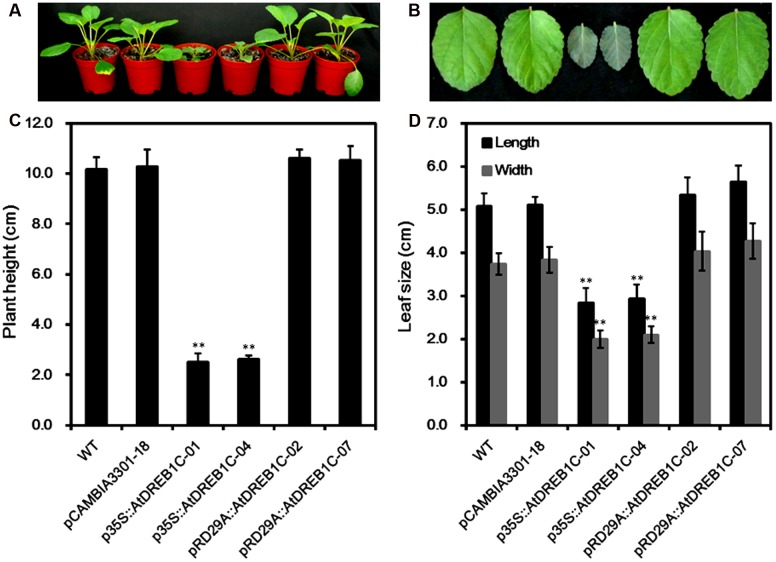
Growth of AtDREB1C transgenic S. miltiorrhiza plants. (A) Wild-type and transgenic seedlings. (B) Wild-type and transgenic leaves. (C) Plant height (cm) in wild-type and transgenic lines. (D) Leaf size (cm) in wild-type and transgenic lines. The labels under the graphs correspond to the plant materials shown in (A) and (B). WT, wild type. The transgenic lines are indicated by the construct names followed by the line number: p35S::AtDREB1C-01 refers to p35S::AtDREB1C line 01 and so on; pCAMBIA3301-18 was used for the positive control. Bars represent the mean + SE of three independent experiments. ∗∗Significantly different at the P < 0.01 level compared to WT.